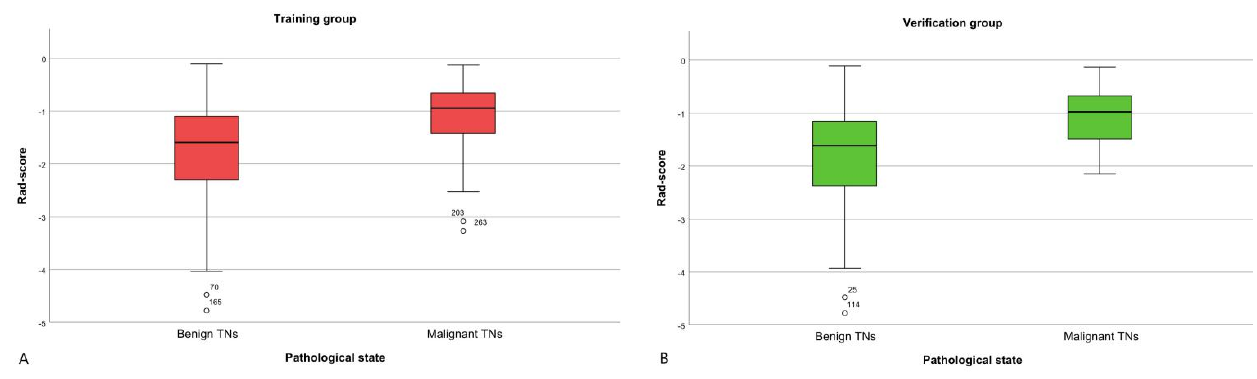
Figure 2. The box-and-whisker plot of the Rad-scores in the training and verification groups. ( A ) Training group. ( B ) Verification group.